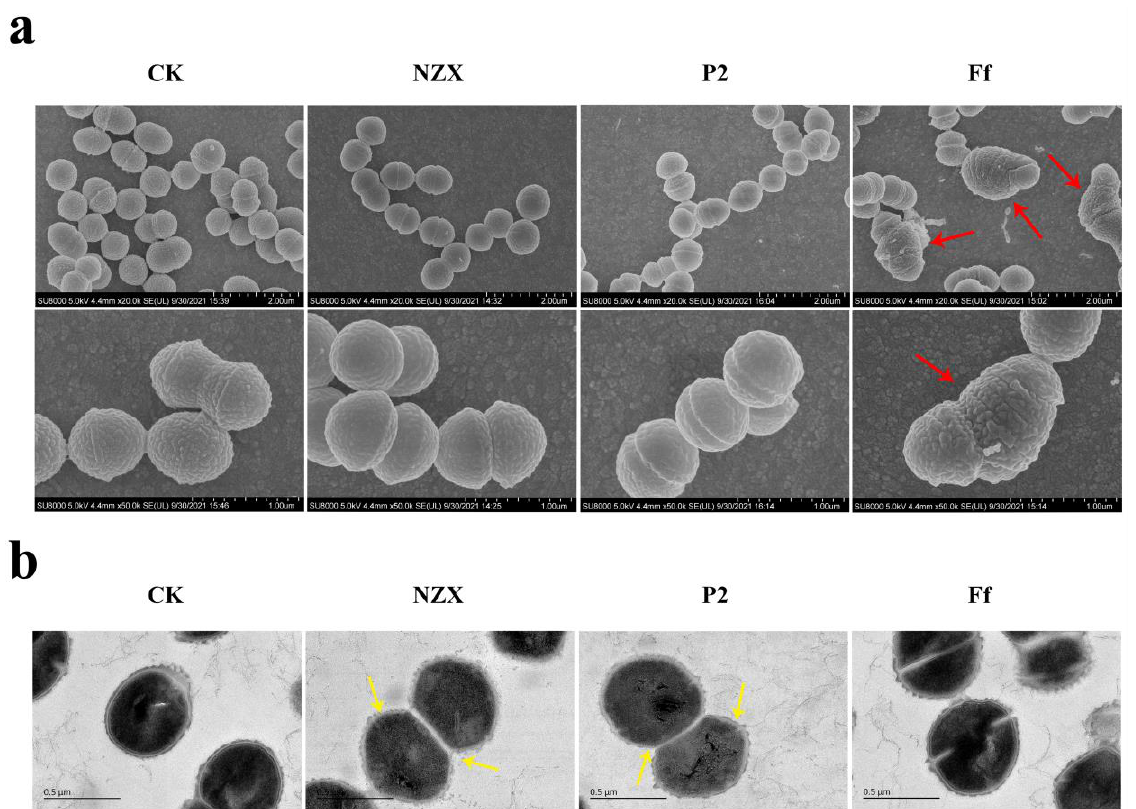
Figure 3. Effects of NZX and P2 on the cell morphology and ultrastructure: ( a ) SEM observations of S. agalactiae ACCC 61733 cells treated with NZX and P2. The S. agalactiae cells were exposed to 4 × MIC NZX and P2 for 2 h, respectively; The red arrows in the Ff treatment group indicate that the cell surface was swollen and deformed, and normal division could not be completed. ( b ) TEM observations of S. agalactiae ACCC 61733 cells treated with NZX and P2. The S. agalactiae cells were exposed to 4 × MIC NZX and P2 for 2 h, respectively; The yellow arrows in NZX and P2 treatment groups indicate that the cell wall became thin, blurred and even the cell’s boundary disappeared.